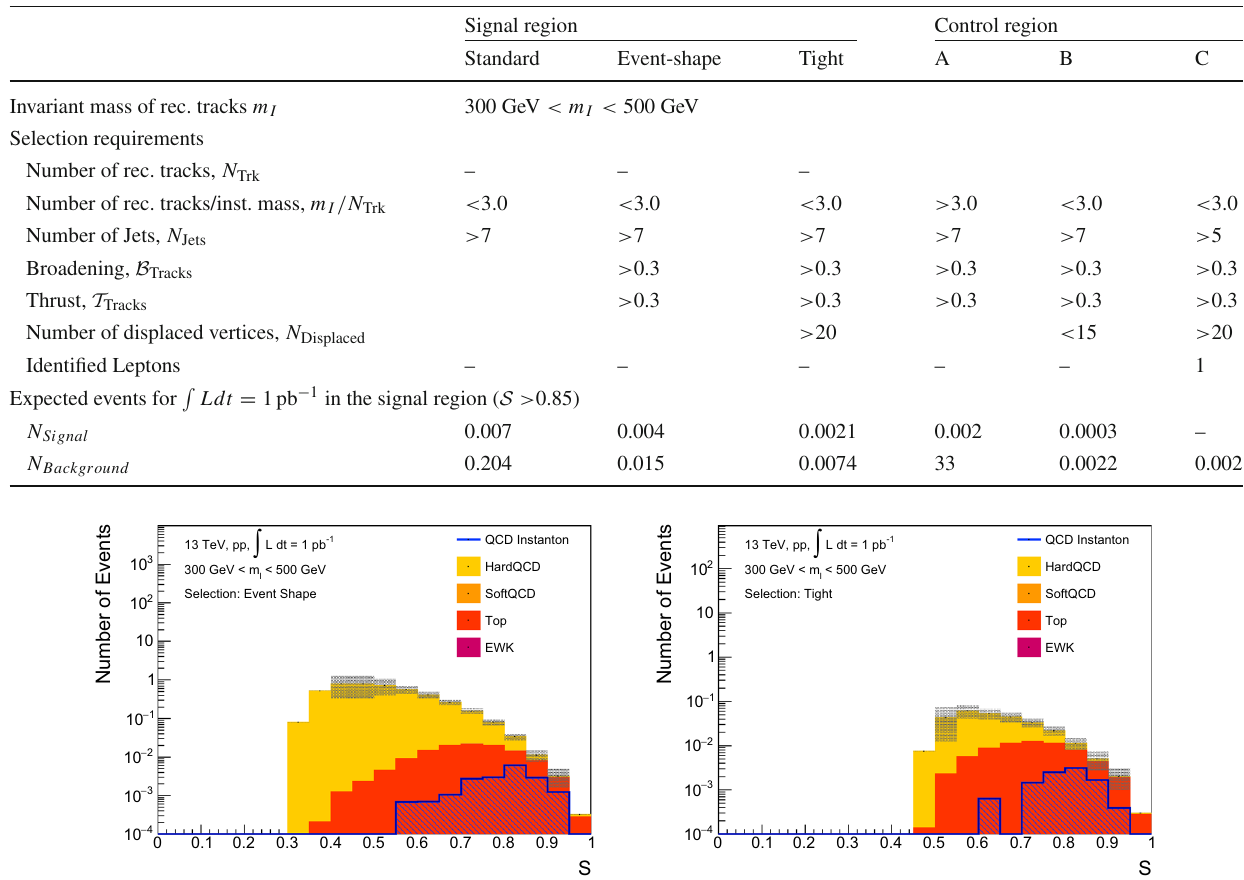
Fig. 18 Predicted distributions of the event sphericity for various pro- cesses,weightedbytheirpredictedcrosssectionsforanintegratedlumi- (cid:8) nosity of L = 1pb − 1 for the event-shape based selection (left) and the tight selection (right). The invariant mass of all reconstructed tracks is